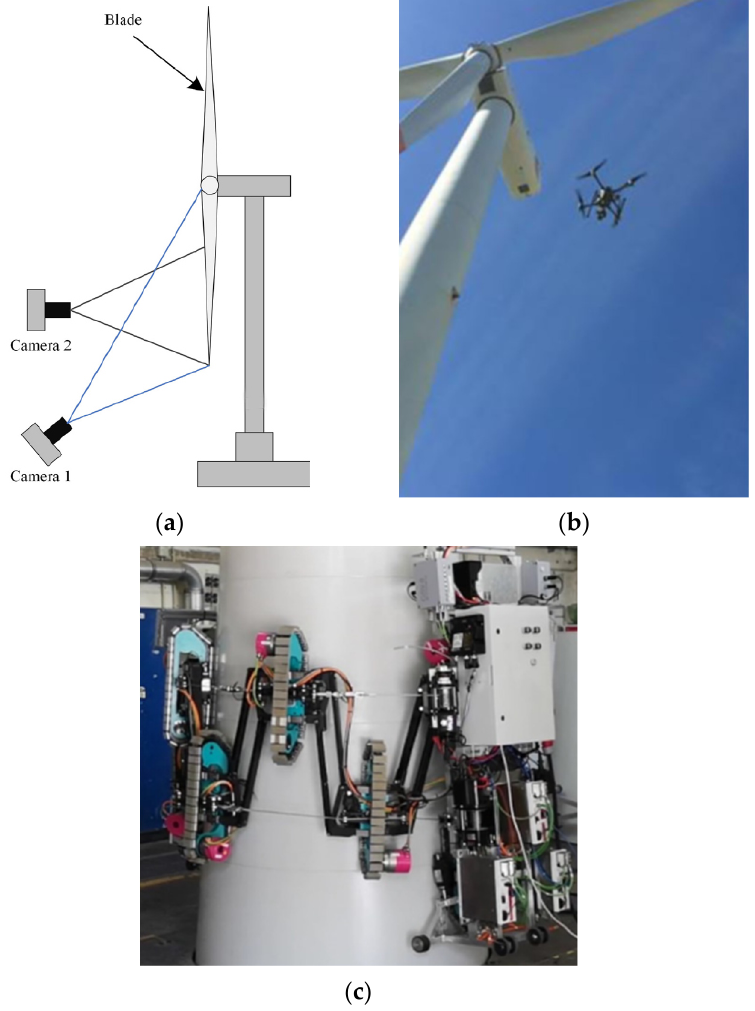
Figure 10. ( a ) Machine vision [67]. ( b ) Data collecting using the UAV [71]. ( c ) Crawling robot [73]. Table 1. List of the advantages and disadvantages of different detection methods [45,59,75,76,79–81]. Test Methods